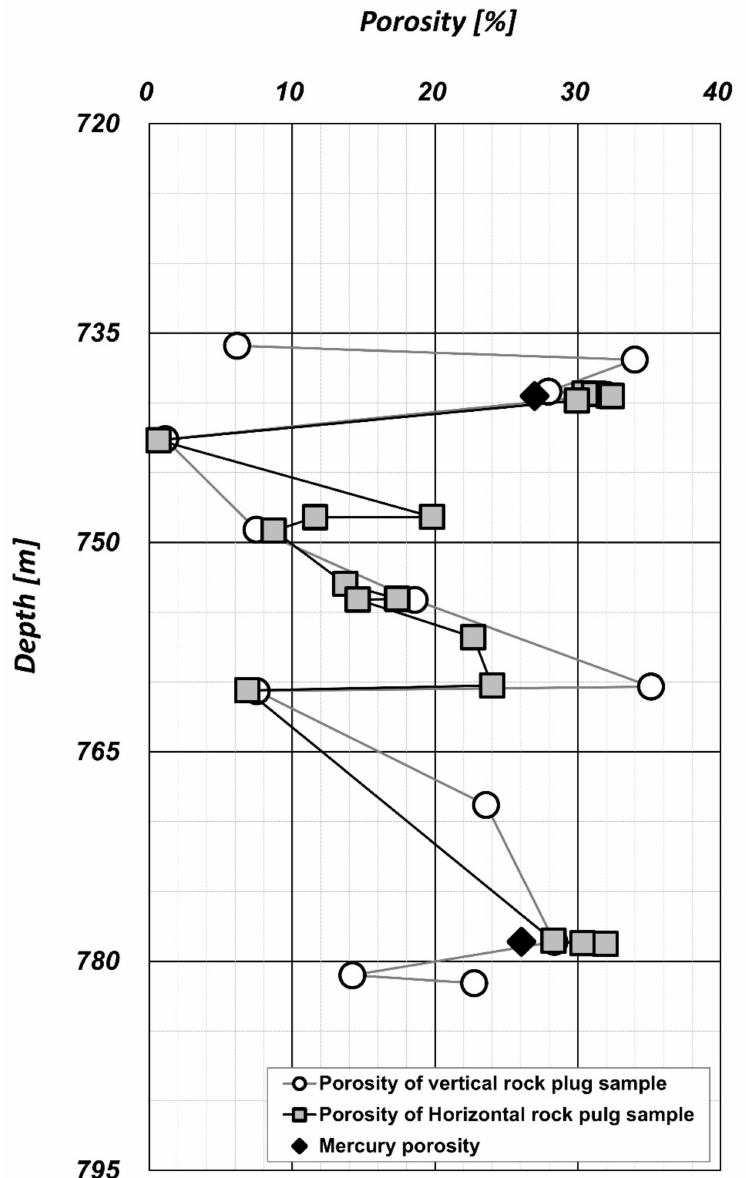
Figure 4. Porosity of plug rock samples determined using helium porosimetry (circles and squares) and mercury porosimetry